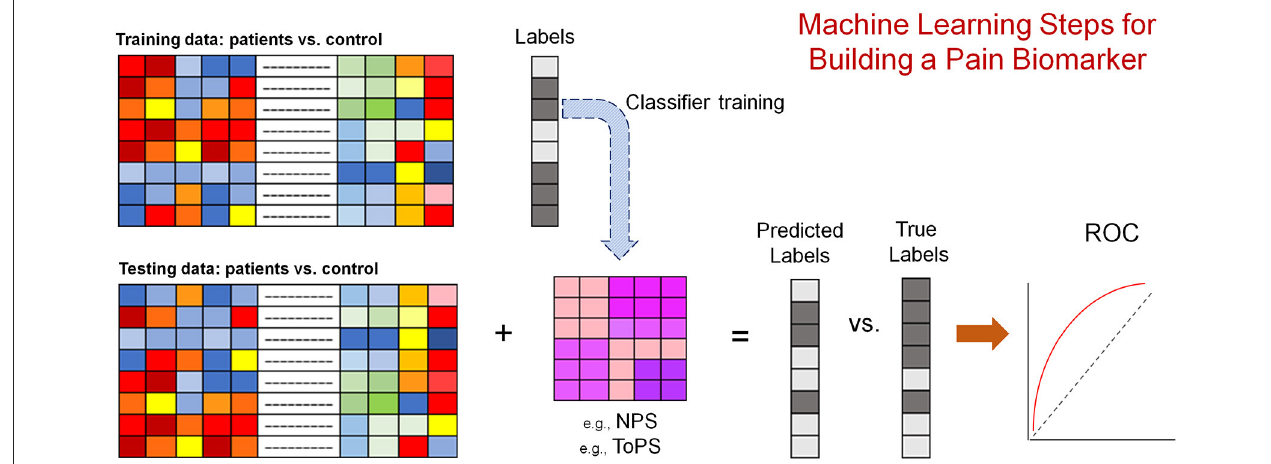
FIGURE 1 | Schematic depiction of the approach used by many papers aimed at developing pain biomarkers. The modality used (i.e., training and testing data) can be the beta maps of the general linear model fit in response to a stimulus [e.g., painful heat (67)], or the connectivity matrix of resting brain activity or structural information [e.g., volume ( 68, 69)]. Labels (i.e., patient or control) is one example of predictions. Pain intensity is often used as a predicted measure. The most rigorous approach is to keep training and testing data totally separate. However, a lot of the published works out there have used k-fold cross validation